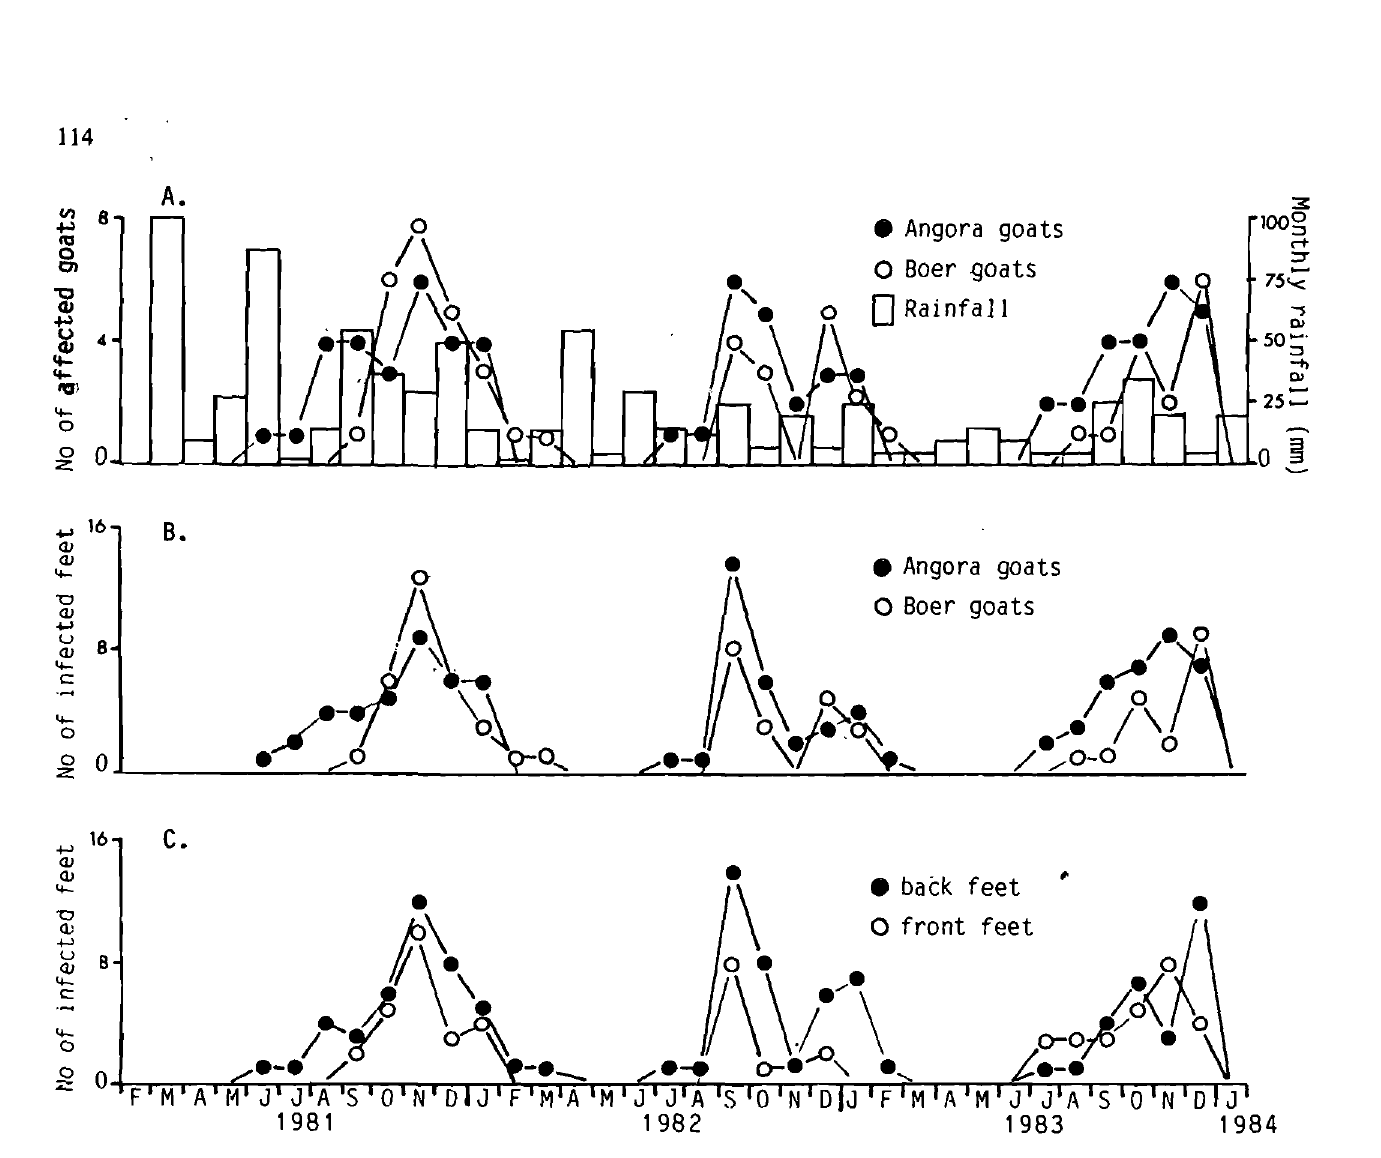
Fig. 1: A. Monthly rainfall and the numbers of goats with abscessed feet B. The number of abscessed feet seen on 10 Angora goats and 10 Boer goats C. The numbers of abscessed front and back